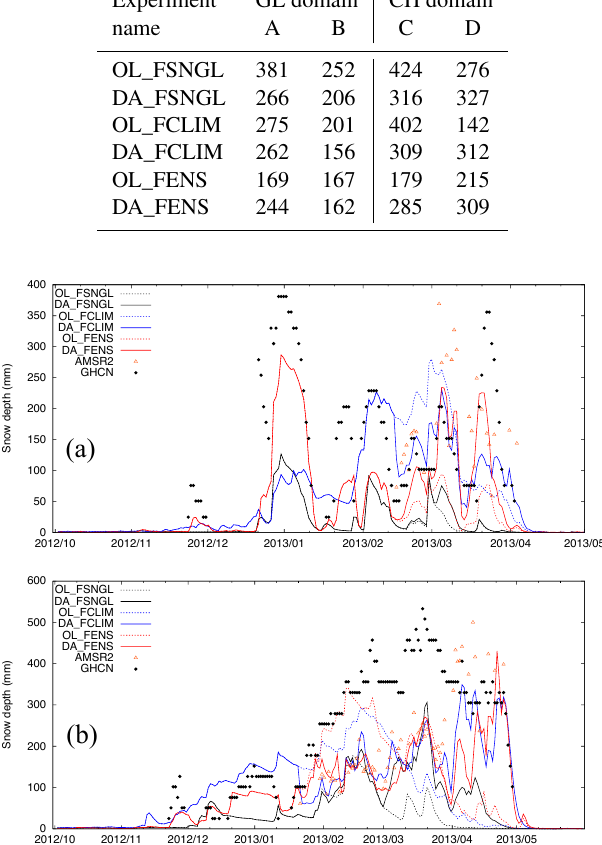
Figure 6. Time series of snow depth fields at location A (a) and B (b) from model open loop (OL_FSNGL, OL_FCLIM and OL_FENS), data assimilation (DA_FSNGL, DA_FCLIM and DA_FENS), AMSR2 and in situ